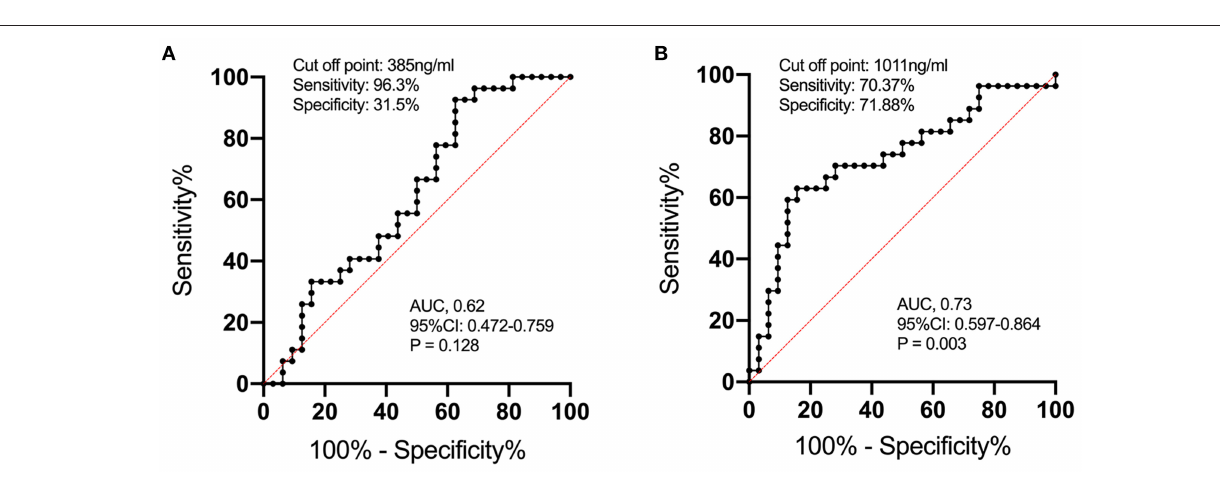
serum MMP-9 level > 1,011 ng/ml (OR 7.218, 95% CI 1.826–28.533, P = 0.005) were independent risk